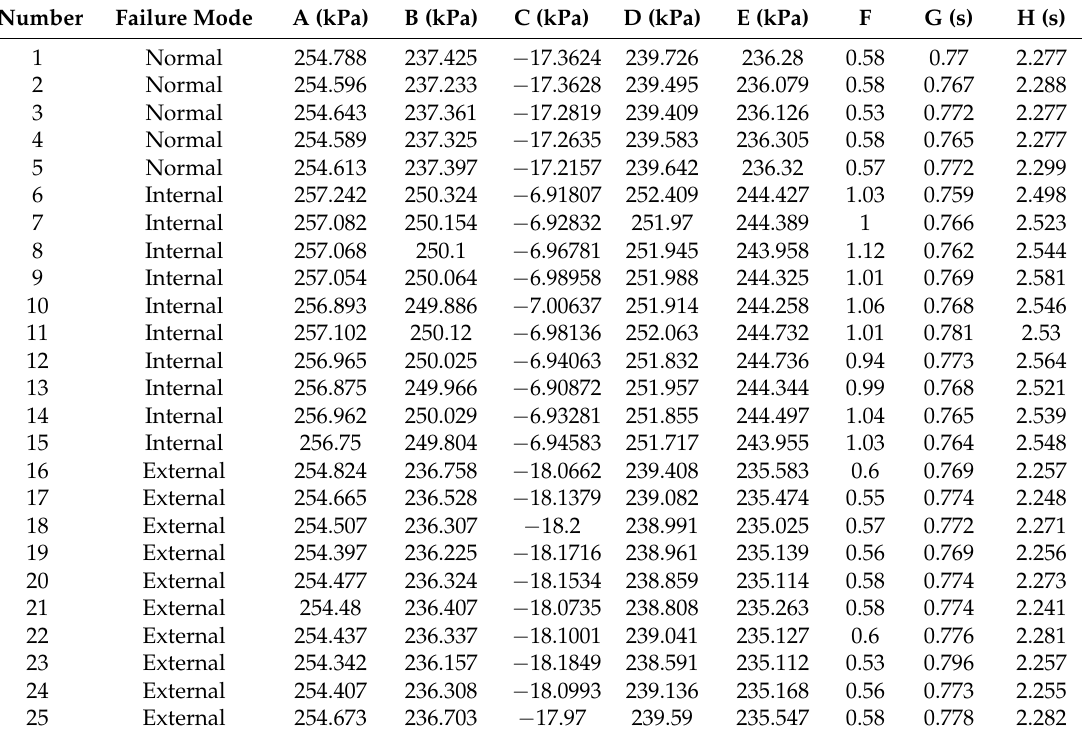
Table 4. Fault characteristic parameters.